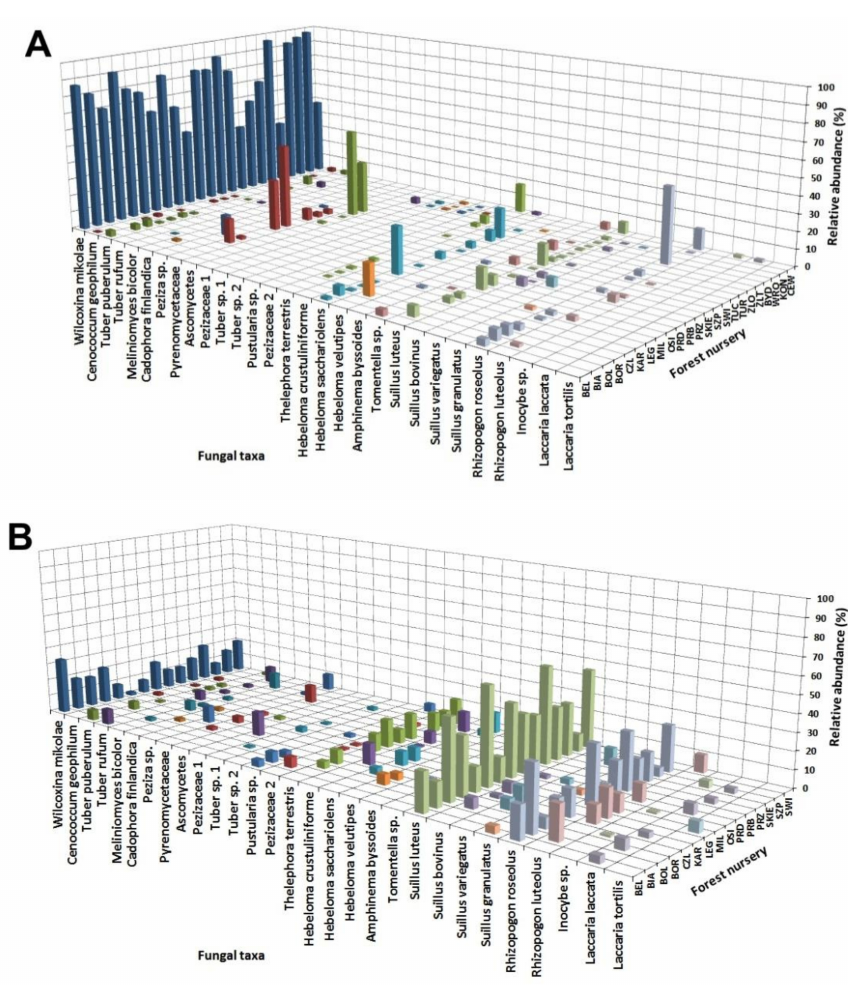
Figure 2. Relative abundance and frequency of ectomycorrhizal fungal taxa noted on 1-year-old ( A ) and 2-year-old ( B ) Scots pine seedlings in forest bare-root nurseries.